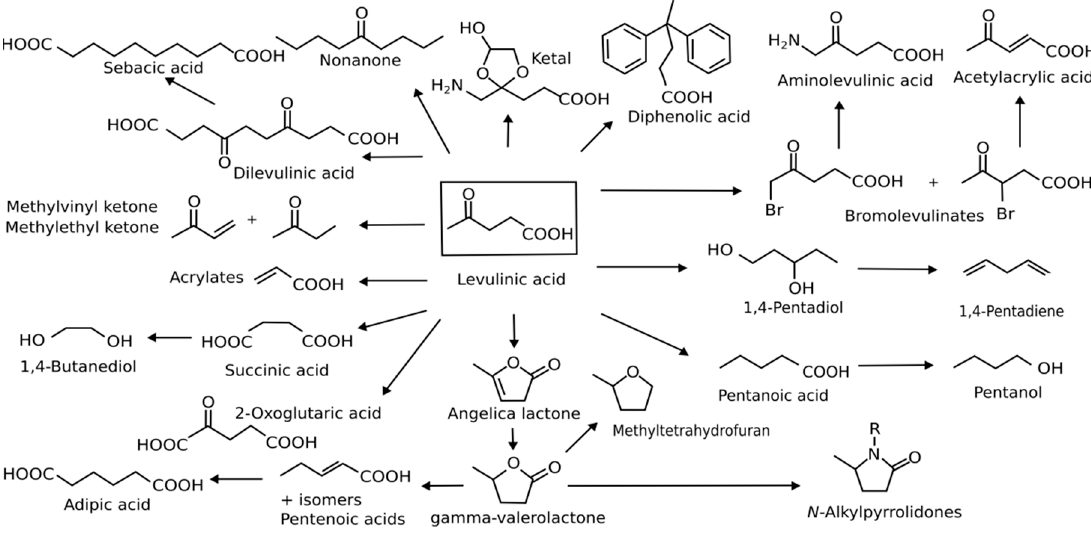
Figure 5. Chemical products derived from levulinic acid.